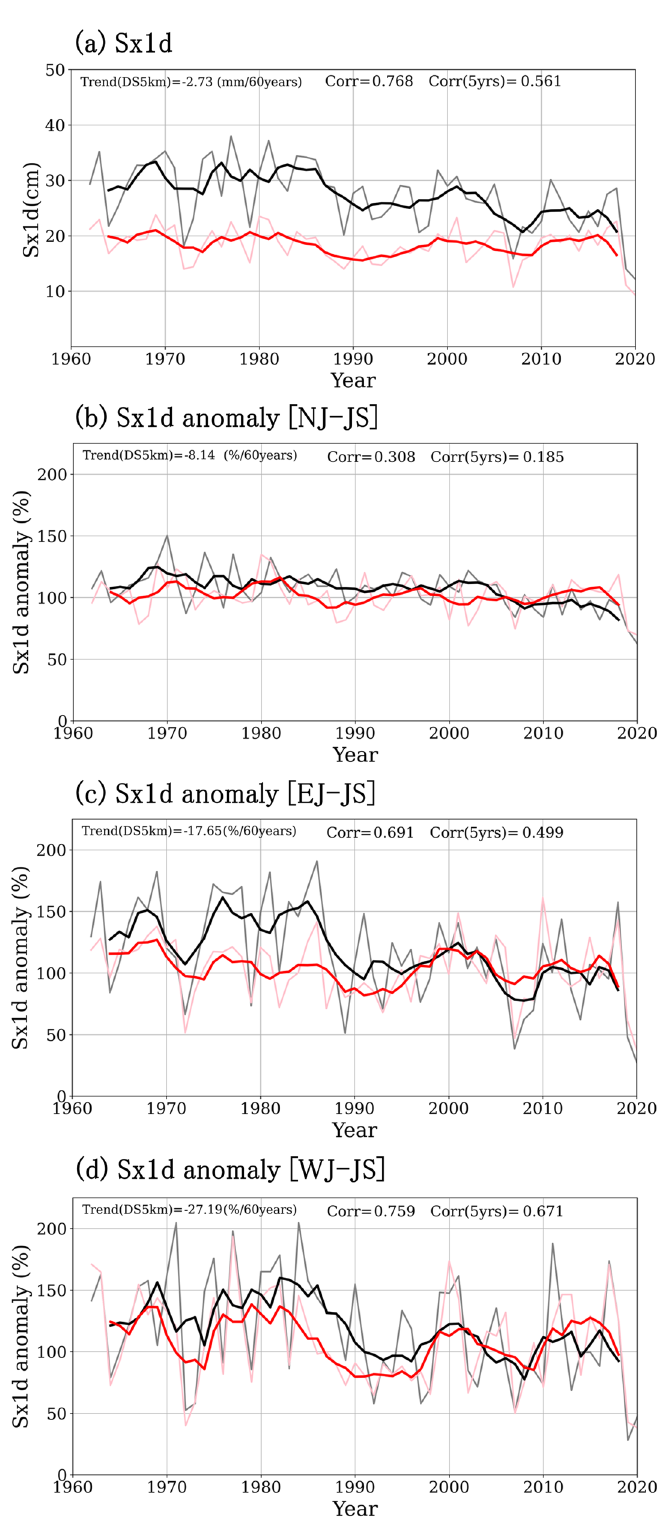
Fig. 6 a Same as Fig. 4, but Sx1d without an observed trend; b – d same as Fig. 5, but Sx1d without observed